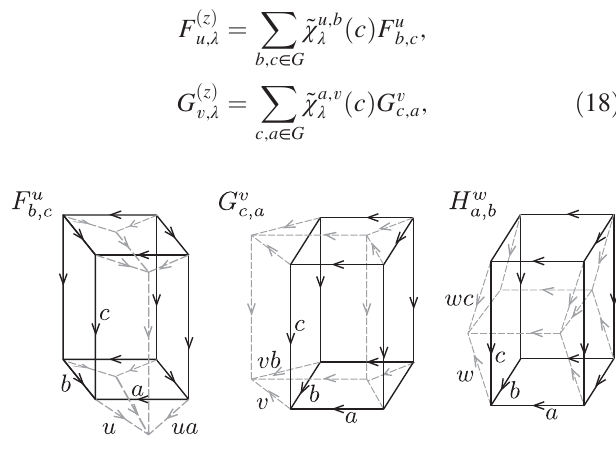
FIG. 9. The action of membrane